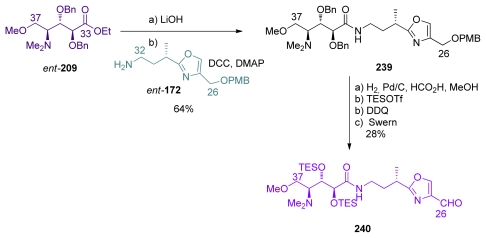
Preparation of C26–C37 fragment 240.